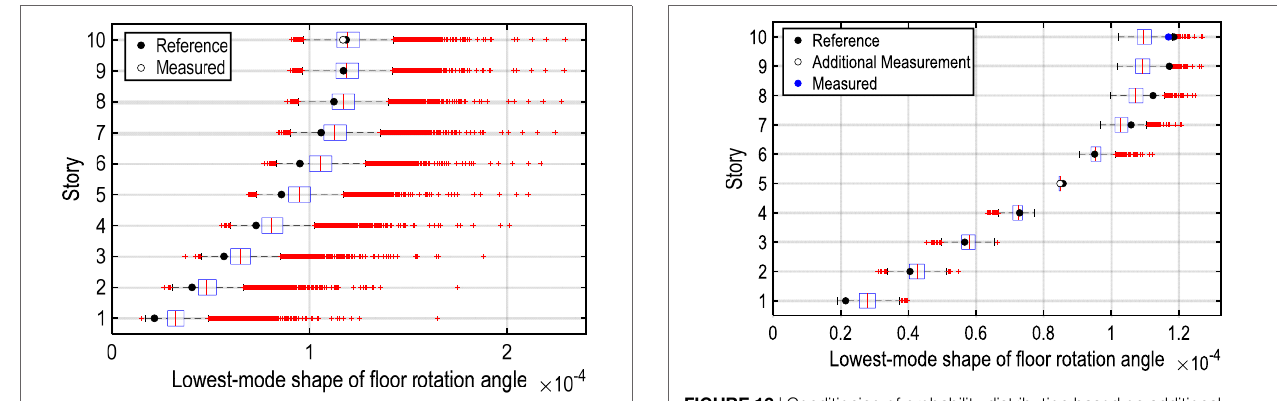
FIGURE 11 | Boxplot of floor rotation angle in lowest mode.